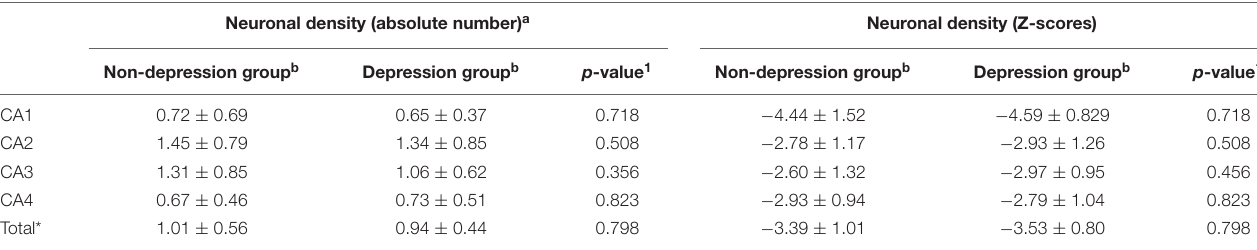
TABLE 3 | Neuronal densities of the entire hippocampus, as well as its four sectors, in absolute numbers and Z -scores, comparing depression and non-depression groups. Neuronal density (absolute number) a Neuronal density